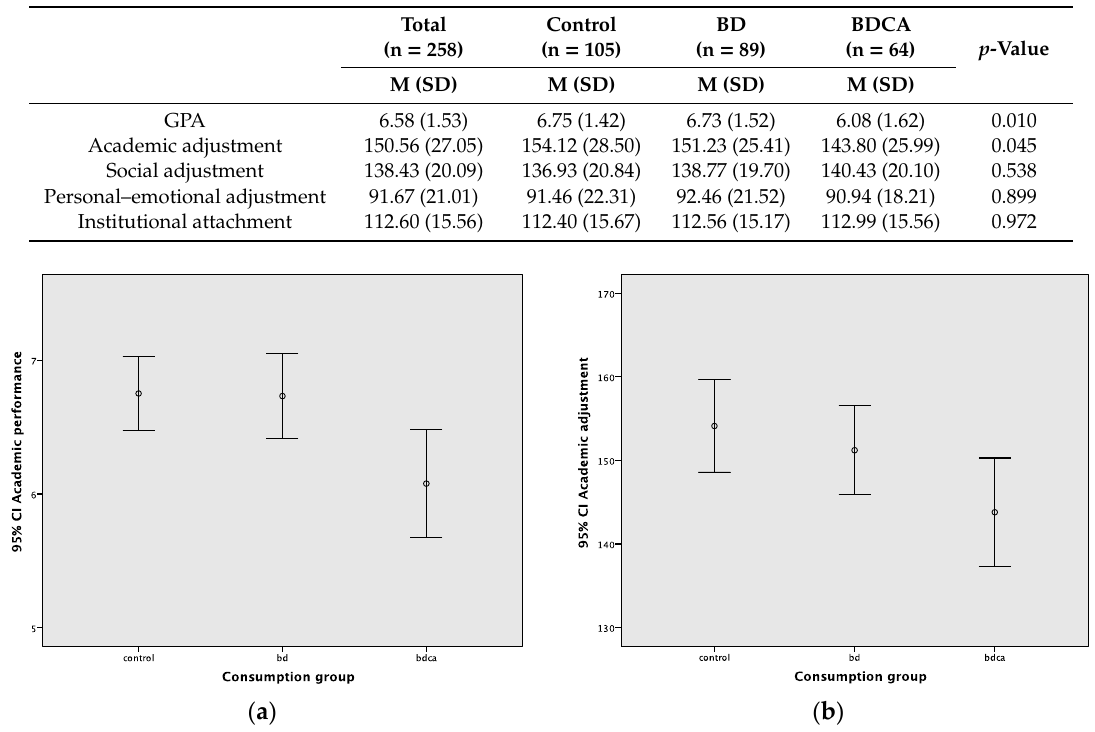
Figure 2. ( a ) Academic performance in the different groups; ( b ) Academic adjustment in the different groups. GPA and academic adjustment were lower in the BDCA group. BD: binge drinking. BDCA: binge drinking and co-consumption of cannabis.